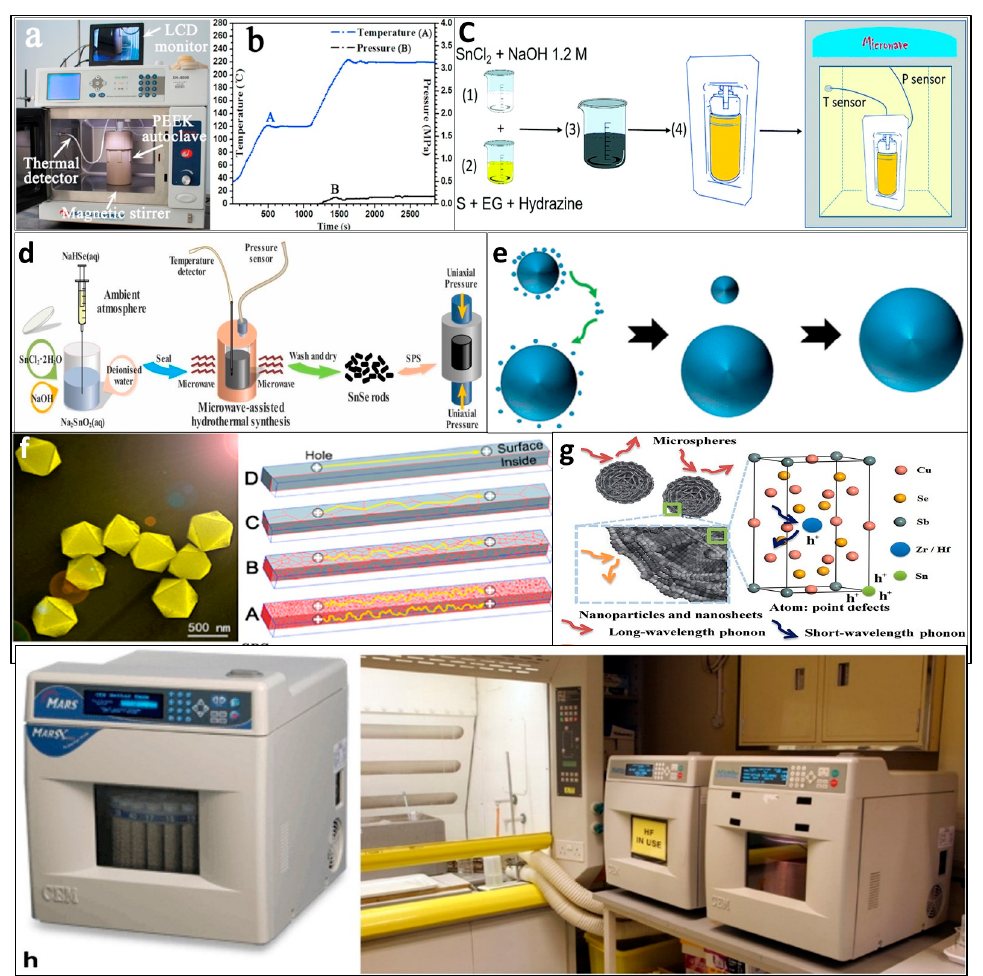
Figure 1. ( a ) Picture depicting main units of the microwave-assisted hydrothermal (MH) synthesis system.